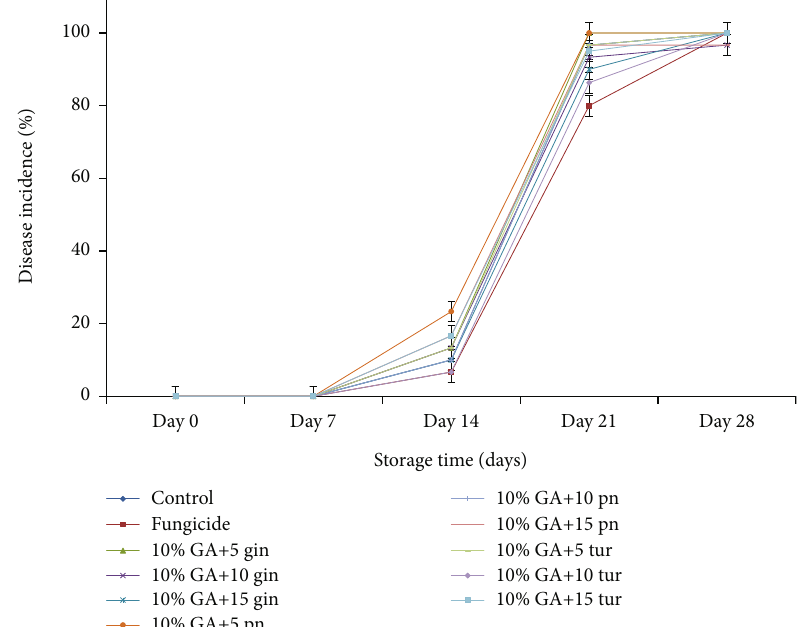
Figure 1: E ff ect of 10% GA incorporated with plant extracts at di ff erent concentrations on disease incidence during cold storage for 28 days. 10% GA+5 gin, 10% GA+10 gin, and 10% GA+15 gin mean 10% gum arabic incorporated with 5, 10, and 15 gL -1 of ginger extracts. tur: turmeric crude extract; pn: dukung anak crude extract. The explanation for ginger is similar to dukung anak and turmeric extract.